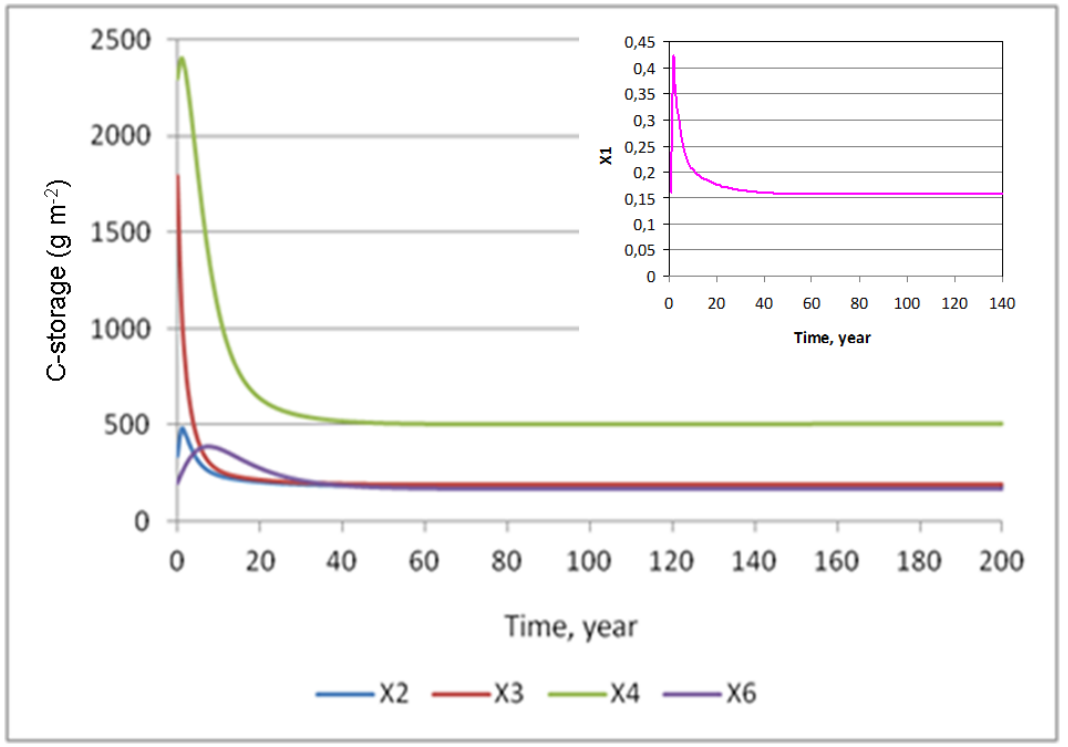
Figure 4. Time-course of X 1– X 4 and X 6 compartment storage values in MCS